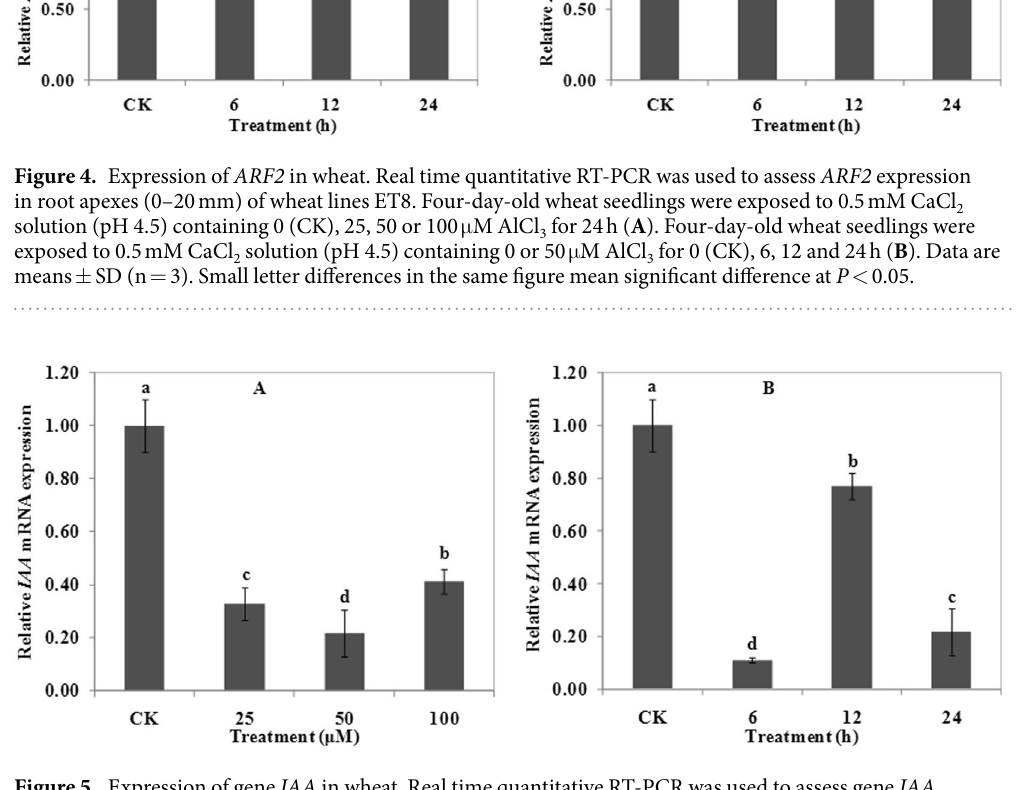
Figure 5. Expression of gene IAA in wheat. Real time quantitative RT-PCR was used to assess gene IAA expression in root apexes (0–20 mm) of wheat lines ET8. Four-day-old wheat seedlings were exposed to 0.5 mM CaCl 2 solution (pH 4.5) containing 0 (CK), 25, 50 or 100 μ M AlCl 3 for 24 h ( A ). Four-day-old wheat seedlings were exposed to 0.5 mM